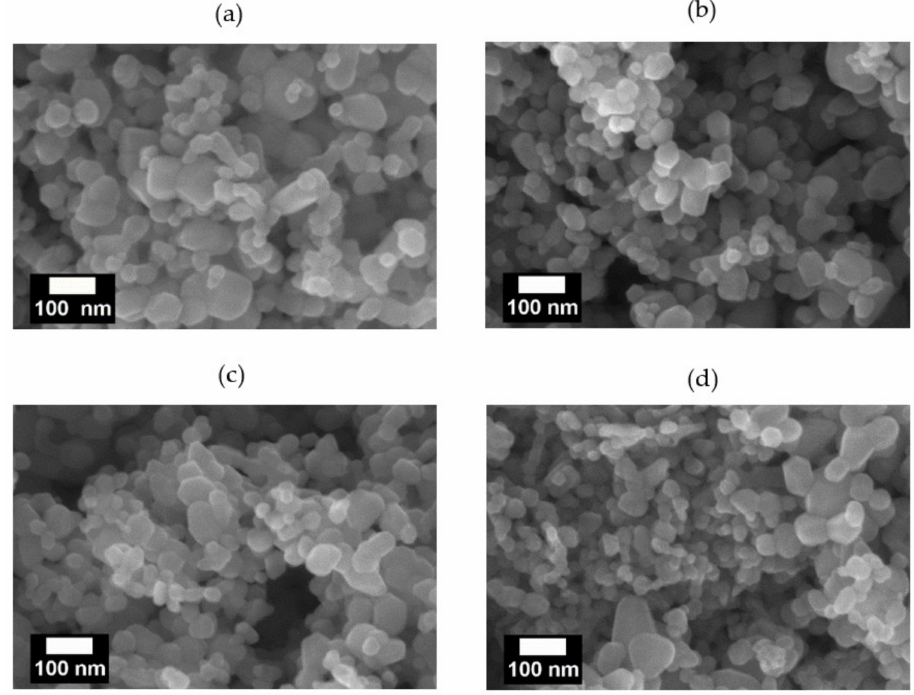
Figure 4. SEM images of ( a ) pristine ZnO NPs, ( b ) Z(0.5S), ( c ) Z(1S), and ( d )